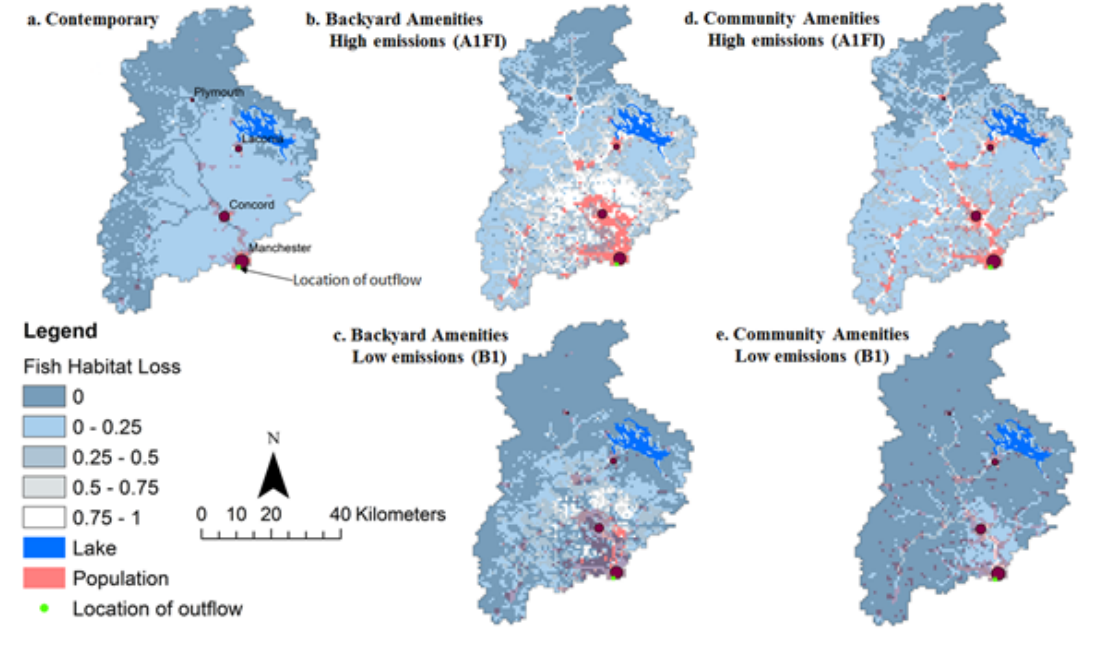
Fig. 8. Map showing the spatial variability of one of the critical ecosystem service indicators (Fish Habitat Loss) as proportion of years when fish habitat loss exceeds impaired levels for the study domain under (a) Contemporary (1980–2005), (b) Backyard Amenities (2075–2100) high emission (top) and low emission (bottom), and (c) Community Amenities (2075–2100) high emission (top) and low emission (bottom). Location of urban population (density > 200/km²) is shown in red in each